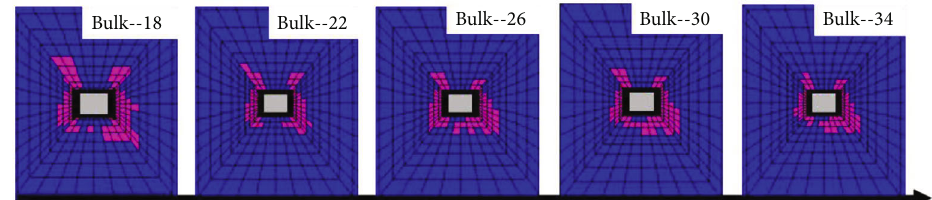
Figure 8: Variation of the plastic zone when the bulk modulus changes.